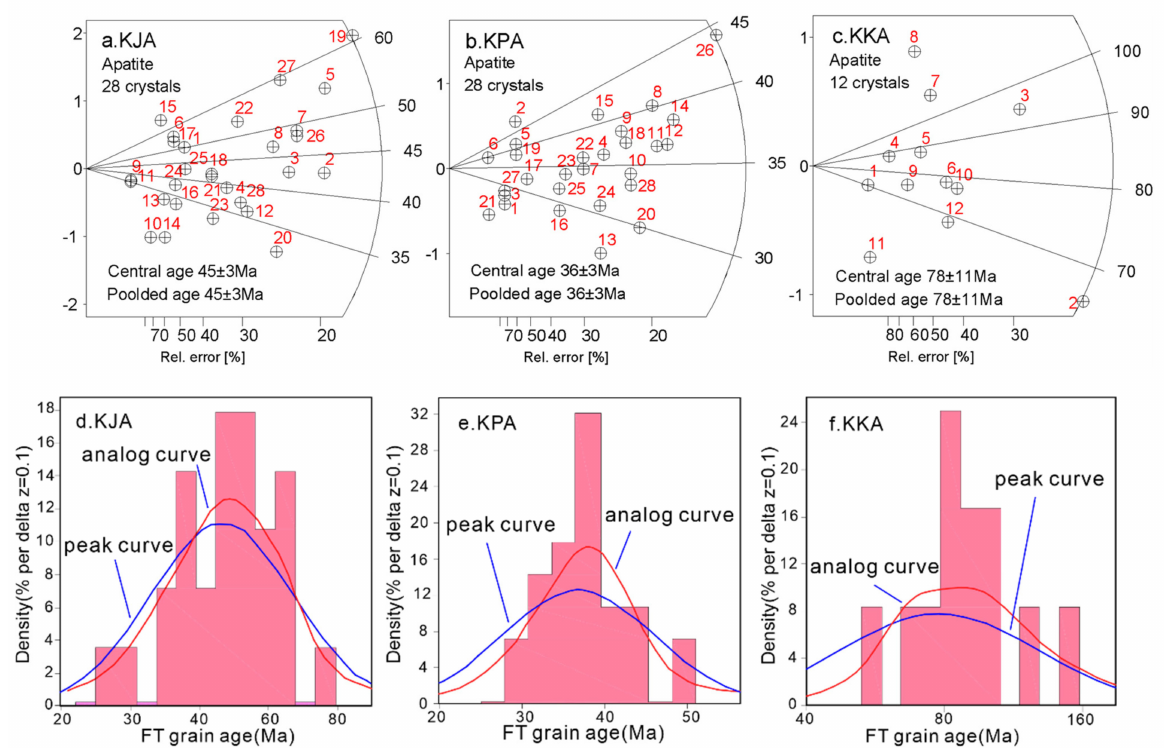
Figure 6. ( a – c ) The grained apatite age radar diagram; ( d – f ) the fission track age frequency distri- bution, ( a , d ) sandstone from the Datong Formation; ( b , e ) sandstone from the Shanxi Formation; ( c , f ) basaltic andesite from the Zuoyun